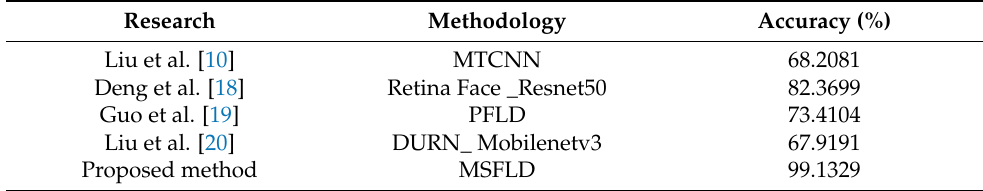
Table 8. Comparison with existing methods on the HNUFDD dataset for fatigue driving be- havior